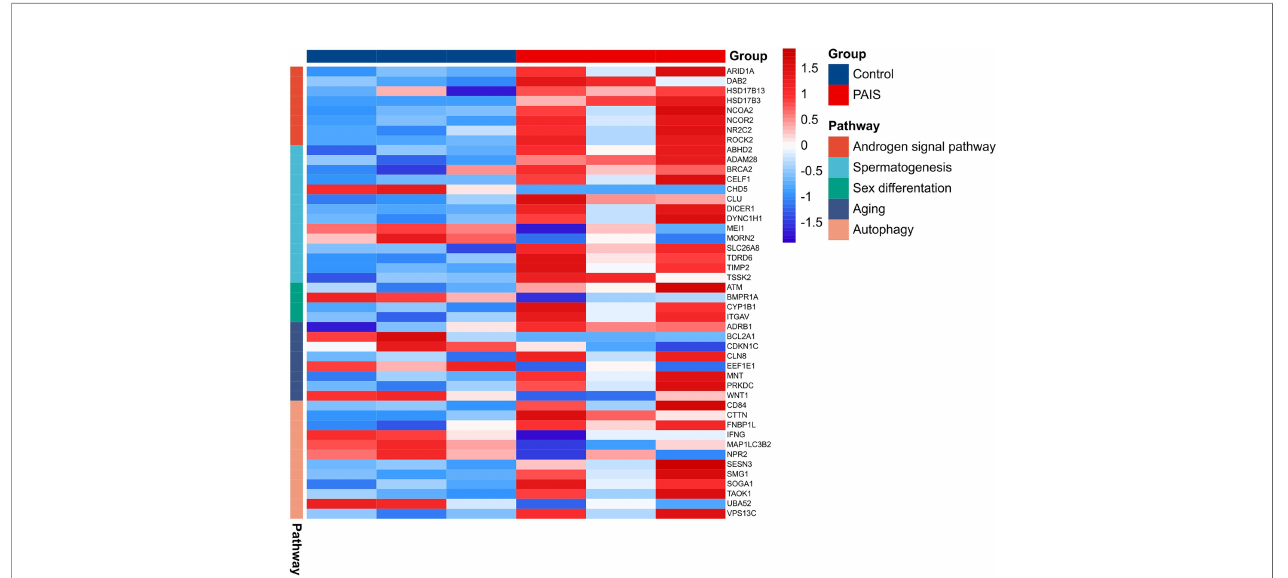
FIGURE 7 | A heatmap of possible related genes in sex